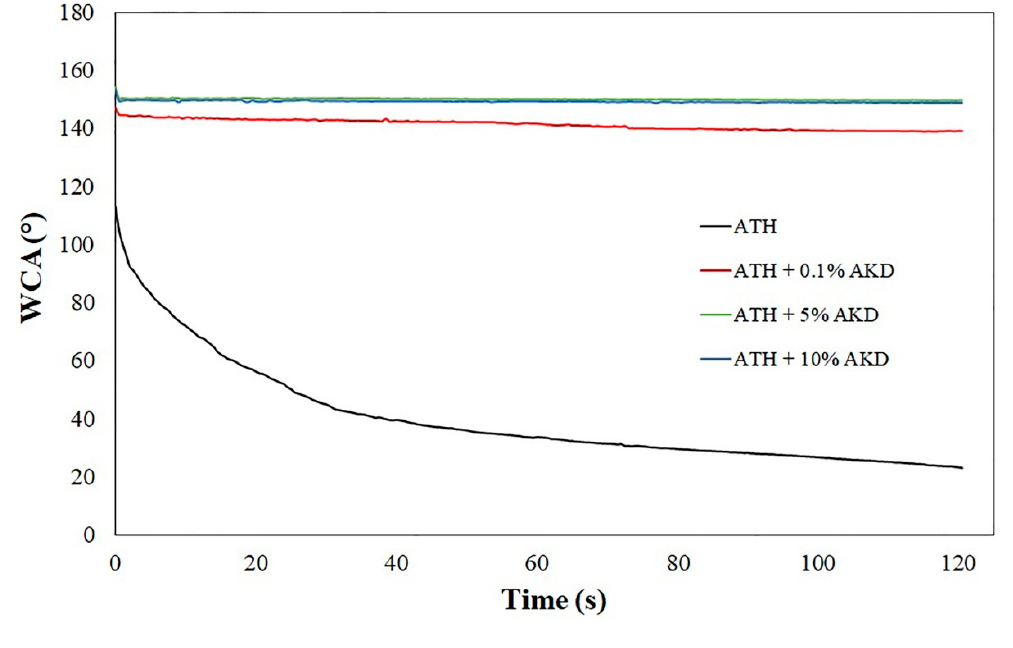
Figure 1. The water contact angle (WCA) during time on untreated alder samples (A), before ( a ) and after UV exposure ( b ).